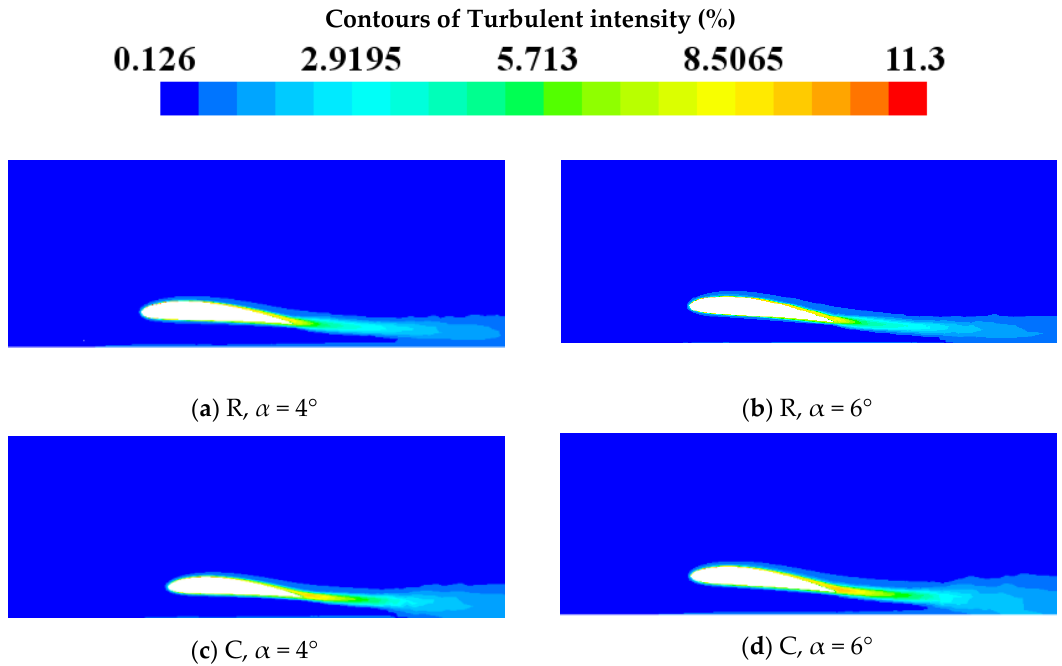
Figure 7. Velocity contours (m/s) at the middle span of the compound wing (C) and the rectangular wing (R) with h/c = 0.15 for various attack angles ( α ).